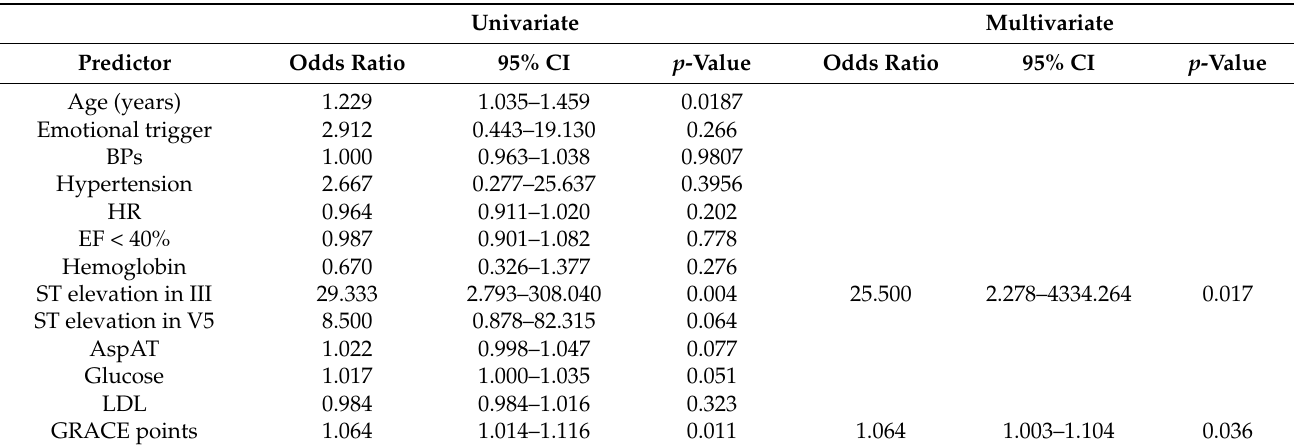
Table 4. Results of the univariate and multivariate logistic regression analyses—risk factors for cardiac rupture in Takot- subo